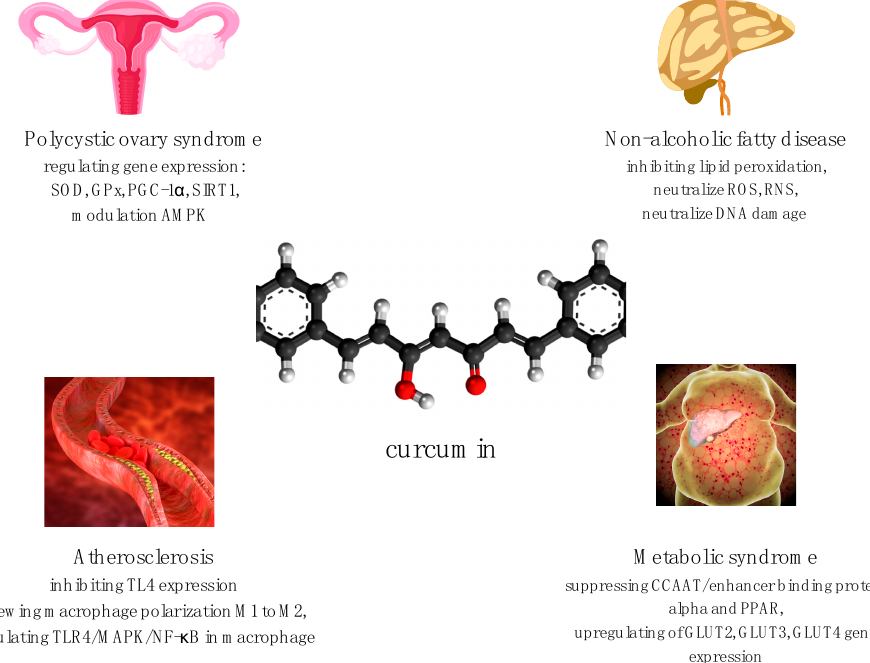
Figure 1. Partial mechanisms of curcumin’s regulation of metabolic properties [15–21]. SOD—superoxide dismutase; GPx—glutathione enzyme peroxidase; PGC-1 α —peroxisome proliferator-activated receptor γ coactivator-1 α ; SIRT1—